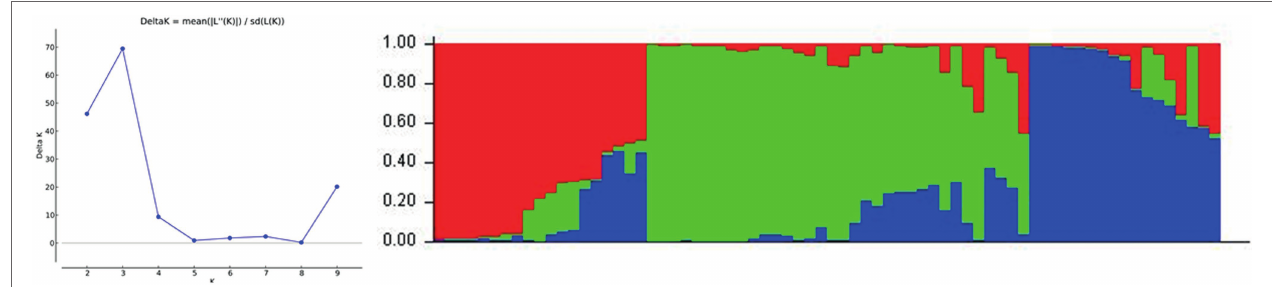
FIGURE 5 | Inferred population structure of 70 oil palm germplasm. Each oil palm individual is represented by a single vertical line. Each color represents one culster. The length of the colored segment indicates the proportion of an individual assigned into one genetic group. The left diagram indicates the true number of genetic clusters.